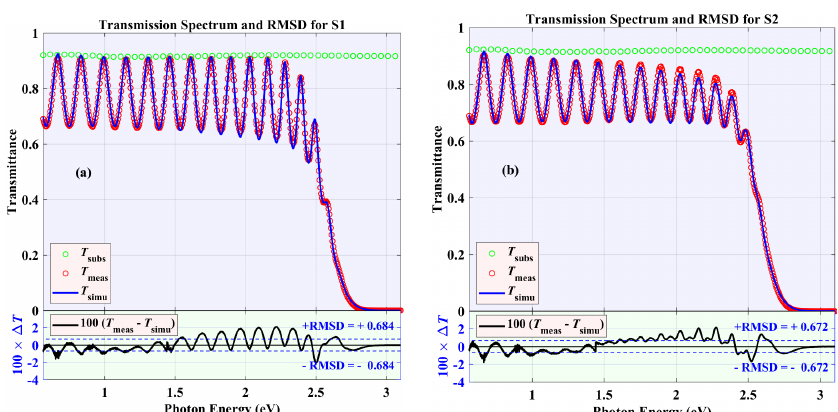
Figure 6. Experimental and best-fit transmission spectra of a representative a -As 33 S 67 chalcogenide film. The difference between the Tauc–Lorentz–Urbach (TLU)-model-generated transmittance spectrum and the as-measured spectrum, for ( a ) spectrum S1, and ( b ) spectrum S2. These two spectra correspond to two crossed areas of the same chalcogenide sample, with two very different values of the wedging parameter. It is noticed the extremely good agreement between the as-measured and generated transmission spectra, with very low values of RMSD of 0.684 and 0.672, respectively. For the sake of clarity, the x -axis represents photon energy when plotting the spectral transmittance, and we have also used open circles instead of solid lines, in order to plot the experimental transmission data for this thinner